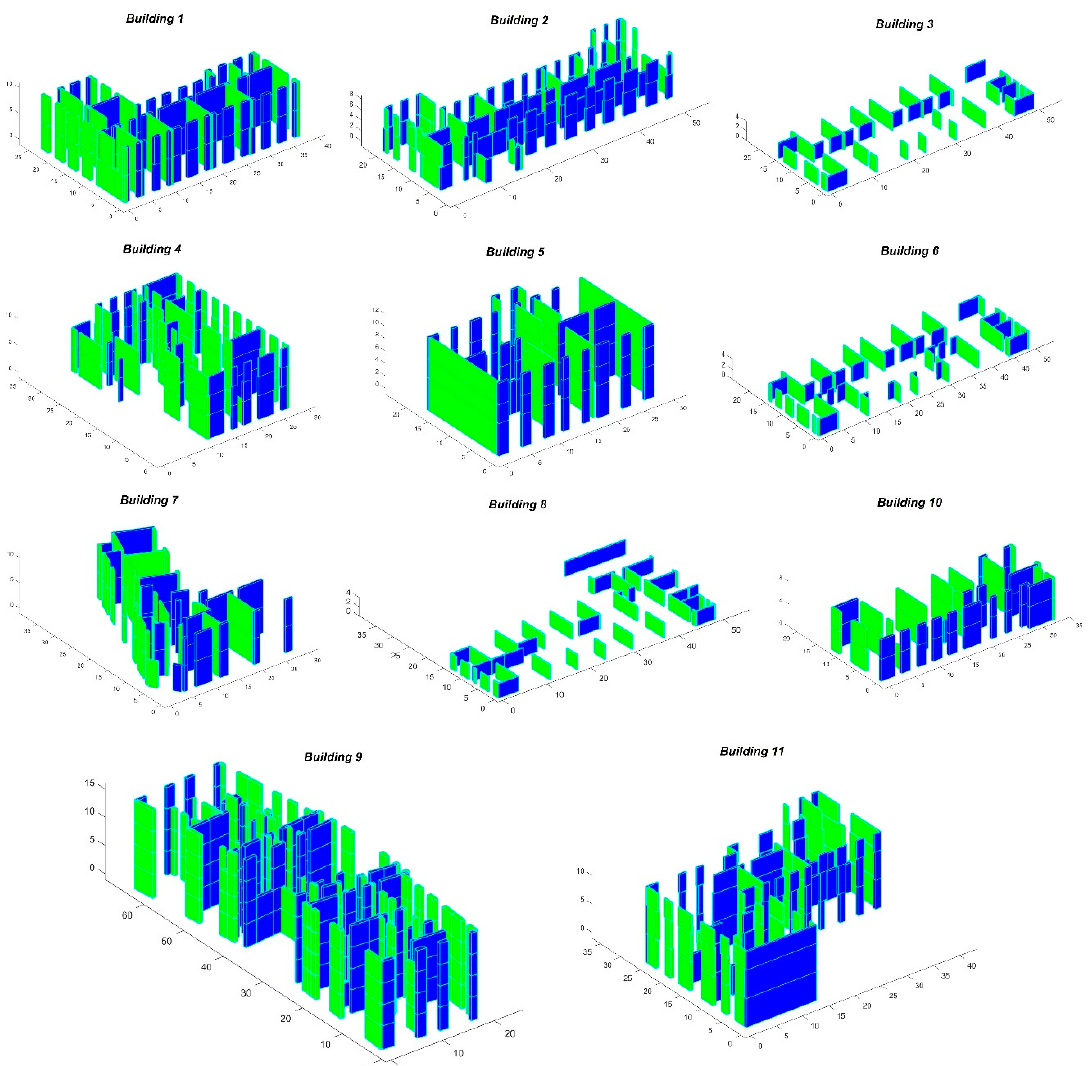
Figure 8. Three-dimensional (3D) layout of the resistant shear walls for the investigated masonry buildings.